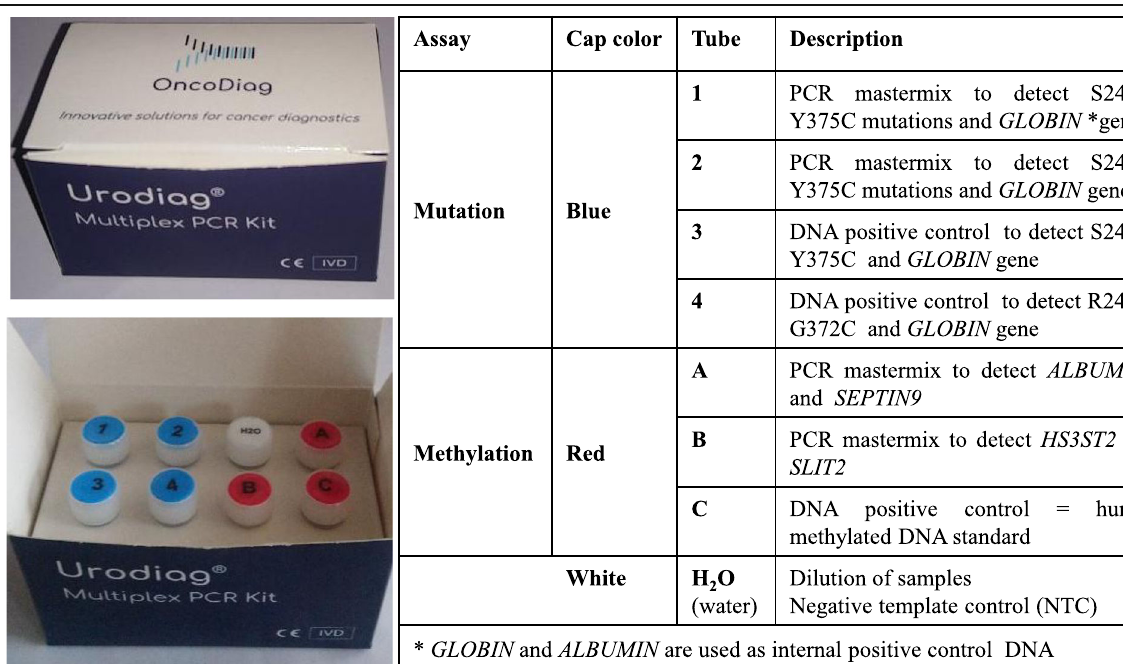
Table 5 Components of the Urodiag® PCR